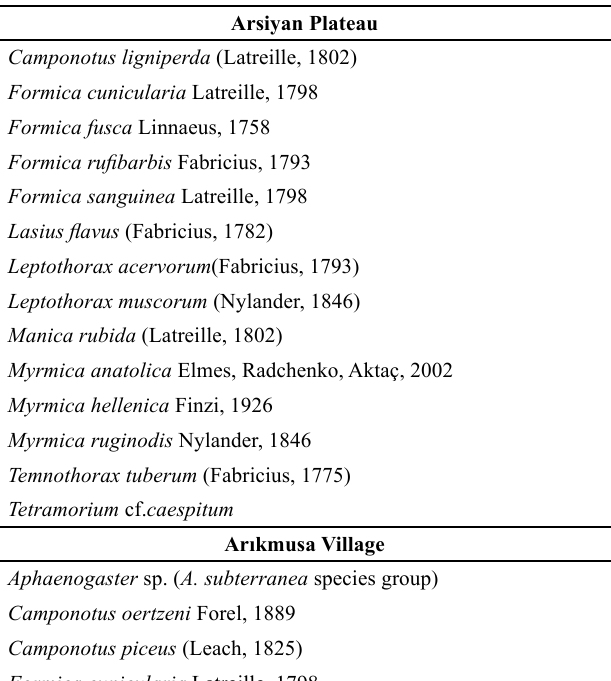
Table 1 . List of ant species collected in the two sites in Turkey. Mounted specimens were measured using a Keyence